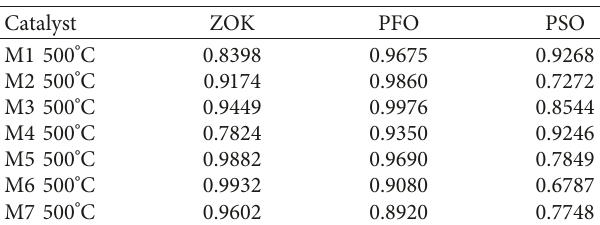
Figure 13: Pseudo-first-order degradation kinetics with different scavengers in 2,4,6-trichlorophenol degradation. Table 4: Adjusted R square for zero-order kinetic (ZOK), pseudo- first-order (PFO) kinetic, and pseudo-second-order (PSO) kinetic models.